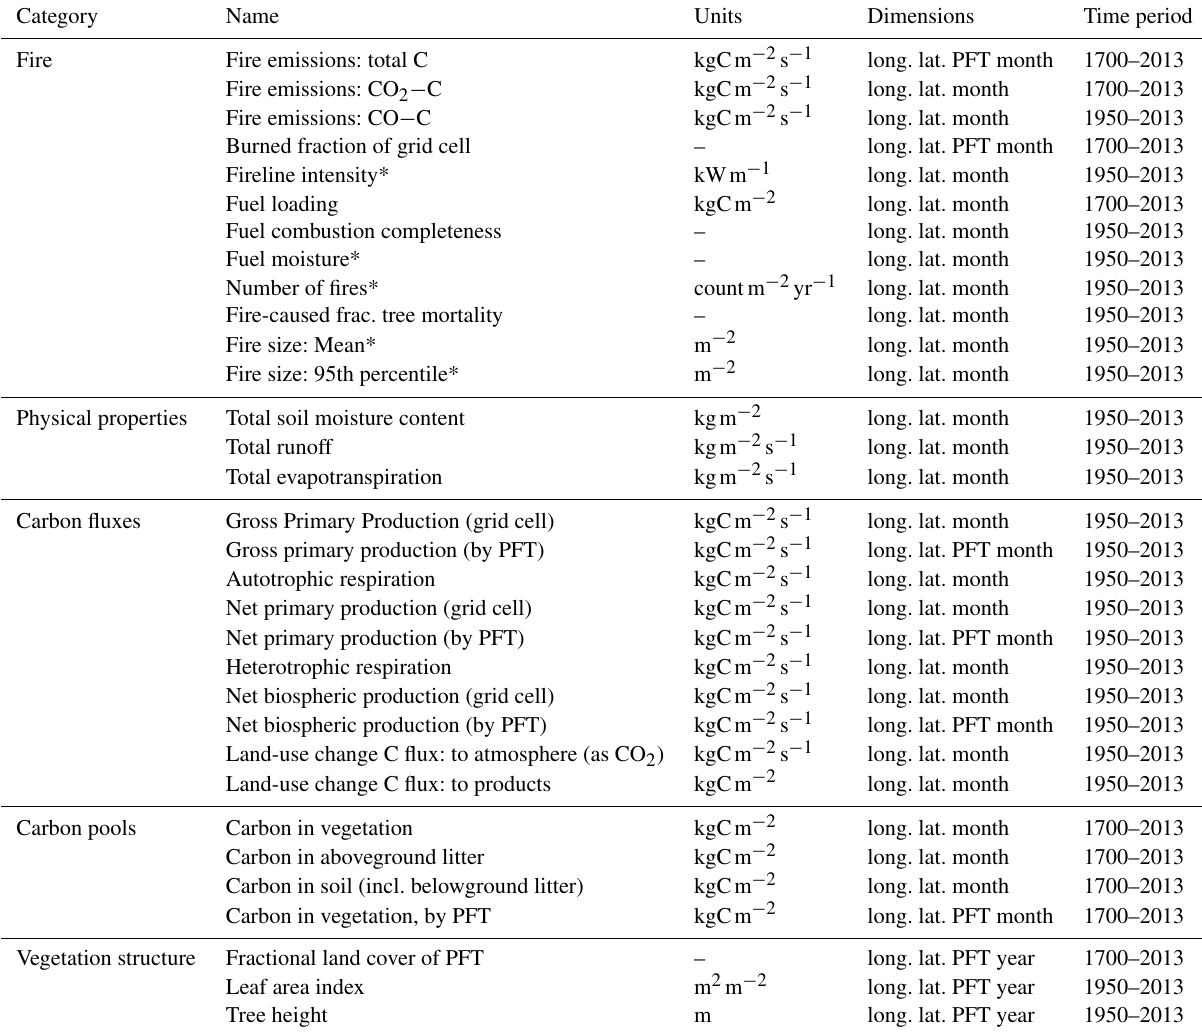
Table 3. Standard output variables. See Table A1 for additional, optional output variables.